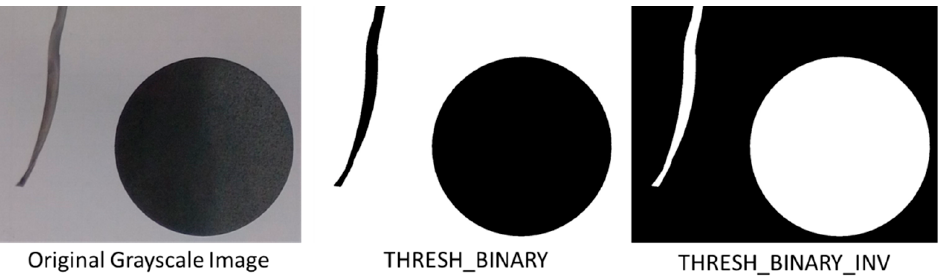
Figure 9. Visual comparison between the original image and the two thresholding types.